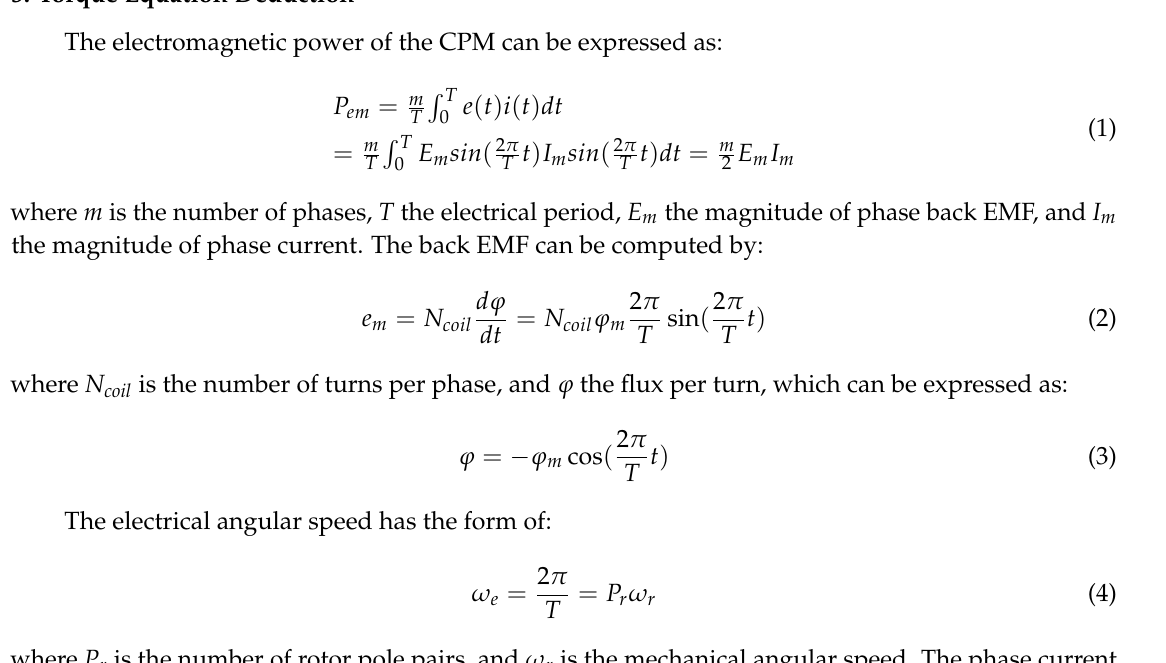
Figure 3. Main parameter and dimension, mesh and no load flux density distribution of a claw pole machine (CPM).